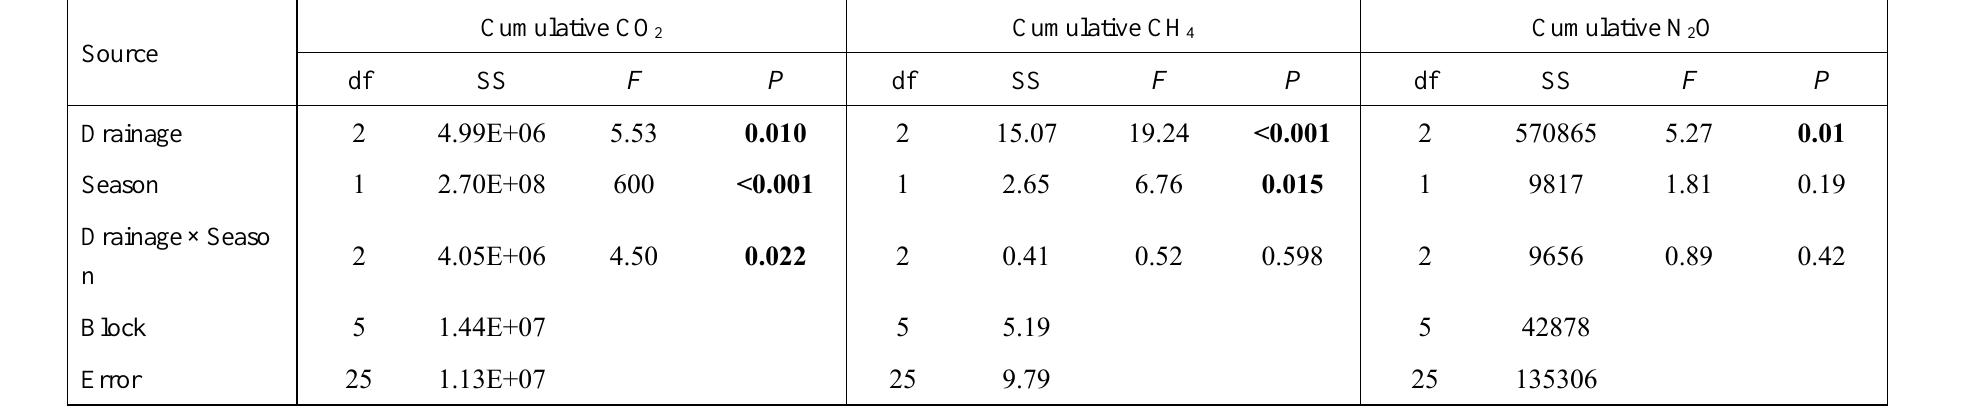
Table A3. Results (Degrees of freedom (df), Sum of squares (SS), F values and P values) of the Linear Mixed Model (LMM) showing the effects of drainage treatment (Drainage), season and their interactions on the cumulative emissions of carbon dioxide (CO Values are considered significant if P < 0.05 (in bold